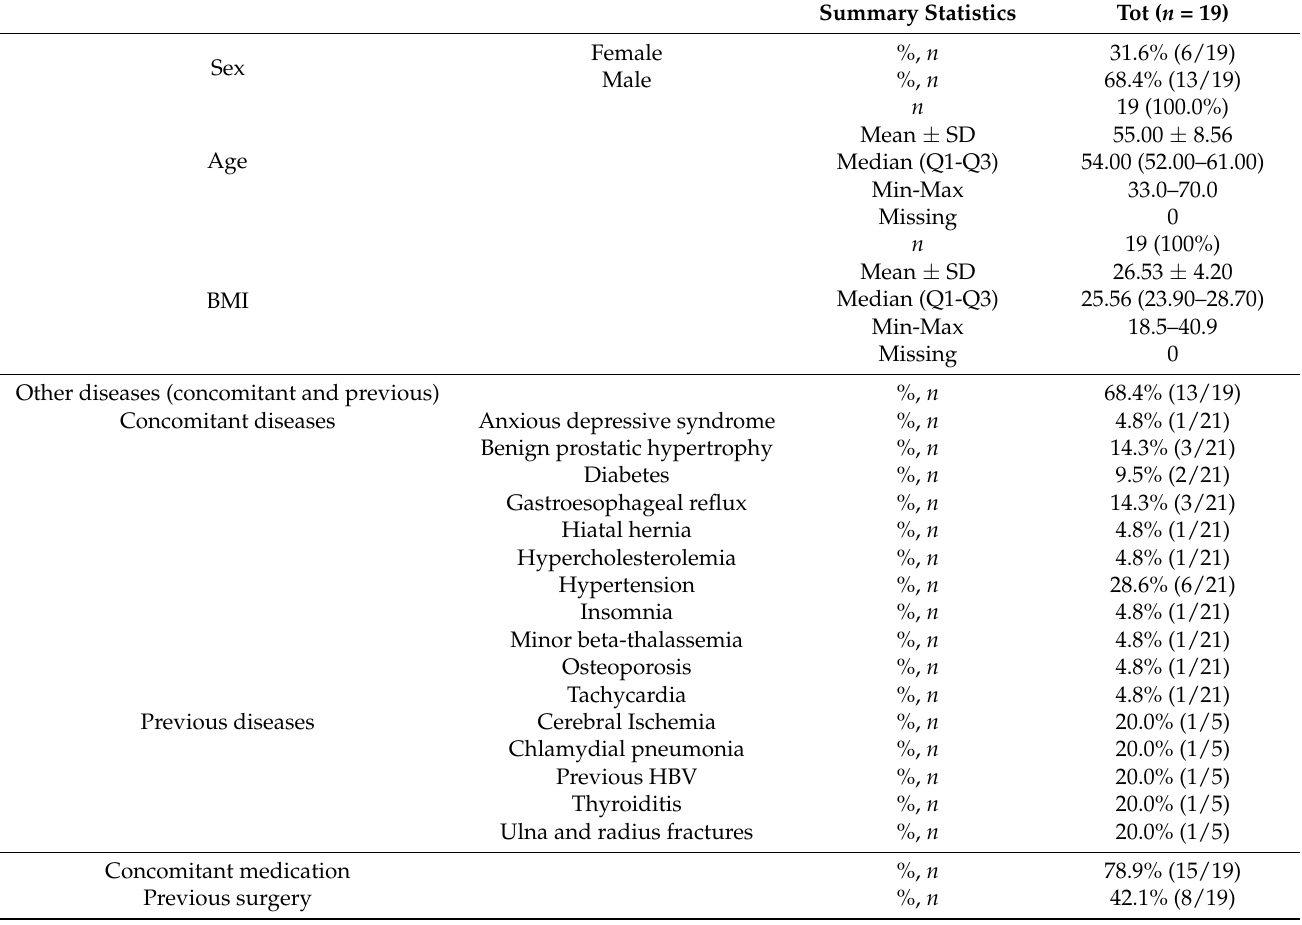
Table 1. Patient characteristics at baseline.